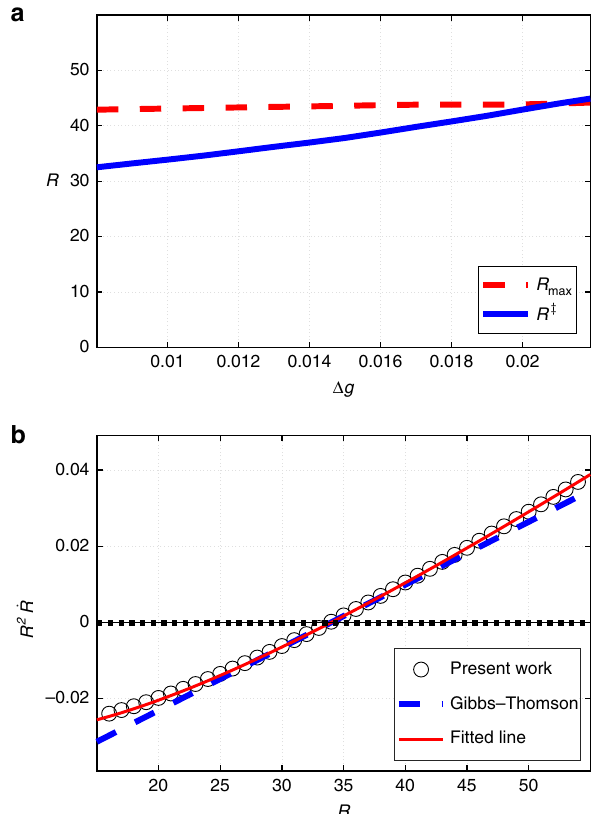
Fig. 6 Size range and the growth rate of clusters. a The Δ g dependences of the critical radius R ‡ and the threshold value of the cluster R max beyond which the cluster becomes mechanically unstable. b The dependence of the rate of volumetric growth of the cluster, as re fl ected in the quantity R 2 _ R , is shown as a function of the cluster ’ s radius. The present data are shown with circles, the corresponding smooth fi t with the thin red line. This is contrasted with with the prediction for the traditional case of nucleation of a stable minority phase, due to Gibbs – Thomson, shown using the dashed blue line. The slope of the latter is chosen to match the present results. Only one point on the curves corresponds to a stationary solution, as in Fig.